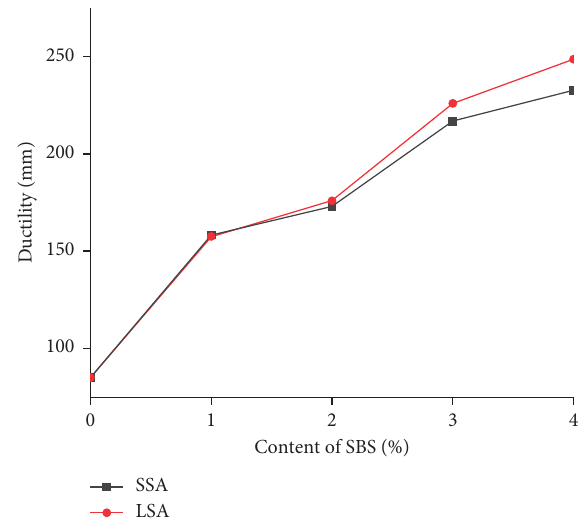
Figure 6: Variation of ductility with the SBS contents for modified